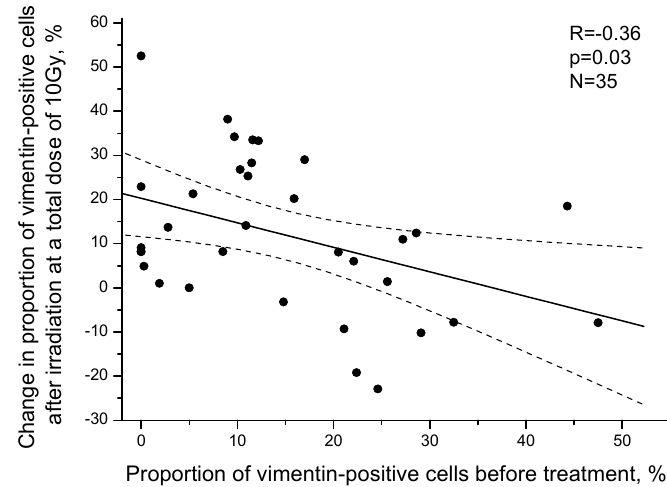
Figure 8. Correlation between the proportion of vimentin-positive cancer cells in the cervical scrap- ings from CC patients before treatment and the change in this indicator after irradiation at a TD of 10 Gy. Positive values on the Y axis indicate an increase in the proportion of vimentin-positive cells after irradiation, whereas negative values indicate a decrease in this indicator. The dotted lines indicate 95% confidence limits for linear regression (solid line).